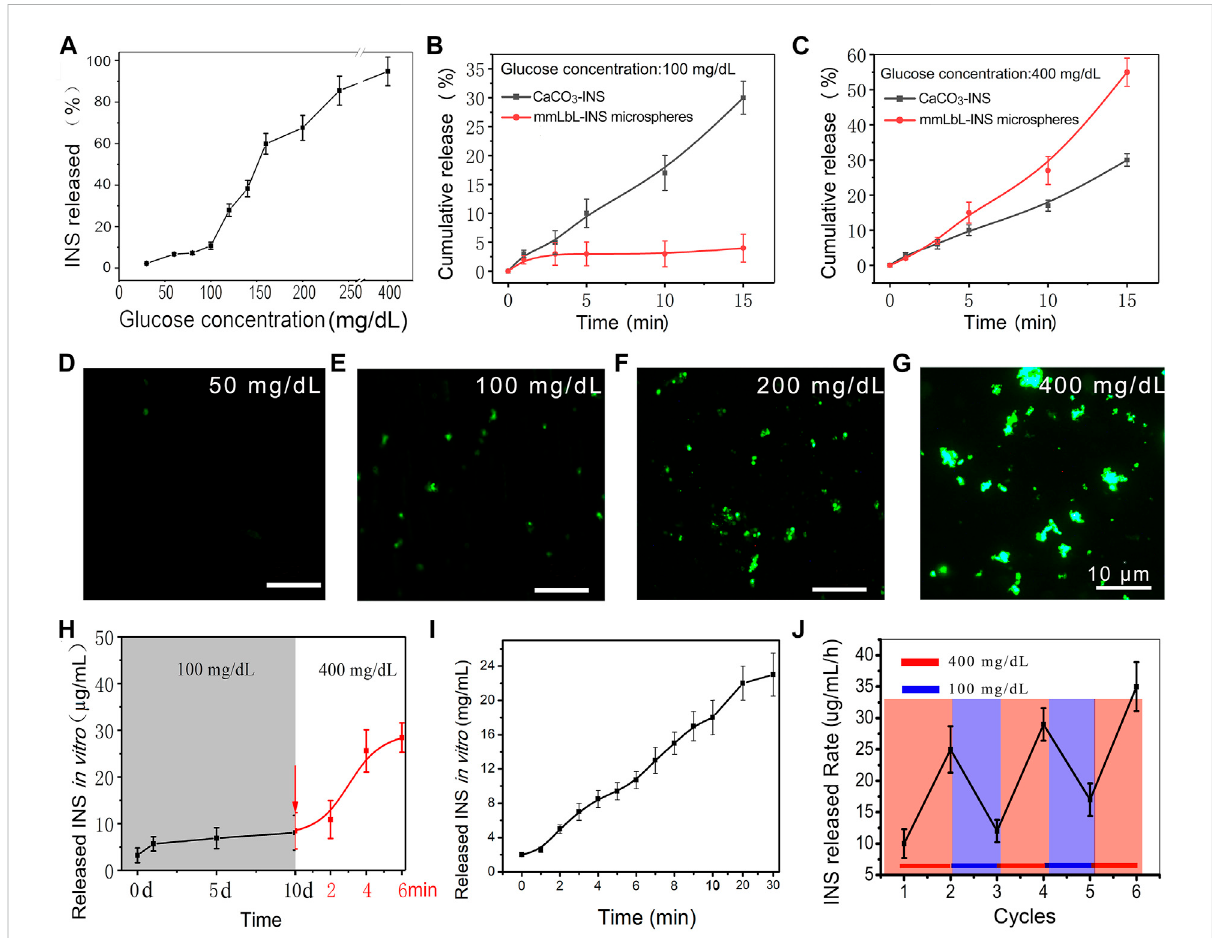
FIGURE 3 Glucose-activated INS release behavior of the mmLbL-INS microcapsules. (A) The INS release behavior at different glucose concentrations (B and C) CumulativeINSreleasebehaviorofmmLbL-INSmicrocapsulesimmersedin100and400 mg/dlglucosesolutions. (D – G) FluorescenceimagesofmmLbL- INSmicrocapsulesthatreleasedINS into themedium after being immersedindifferentglucoseconcentrations(green fl uorescence:FTIC-INS). (H) Stability analysis of the glucose activity effect. After being stored in 5 mmol/L glucose solution at 4 ° C for 10 days, the mmLbL-INS microcapsules released INS invitro (readline)whenimmersedin400 mg/dlglucosesolution. (I) INSreleasebehaviorofthemmLbL-INSmicrocapsuleschangedovertimein400 mg/dl glucosesolution. (J) INSreleaseexhibitedapulsatilepro fi leinresponsetodifferentglucoseconcentrations.ThemmLbL-INSmicrocapsuleswereimmersed in normal (100 mg/dl) or hyperglycemic level (400 mg/dl) solution for several